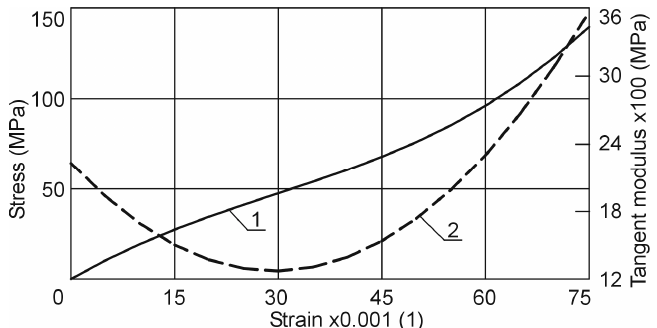
Figure 4. Tensile stress–strain for polyamide 1400dtex/3 cord; 1 – tensile test, 2 – tangential stiffness modulus.